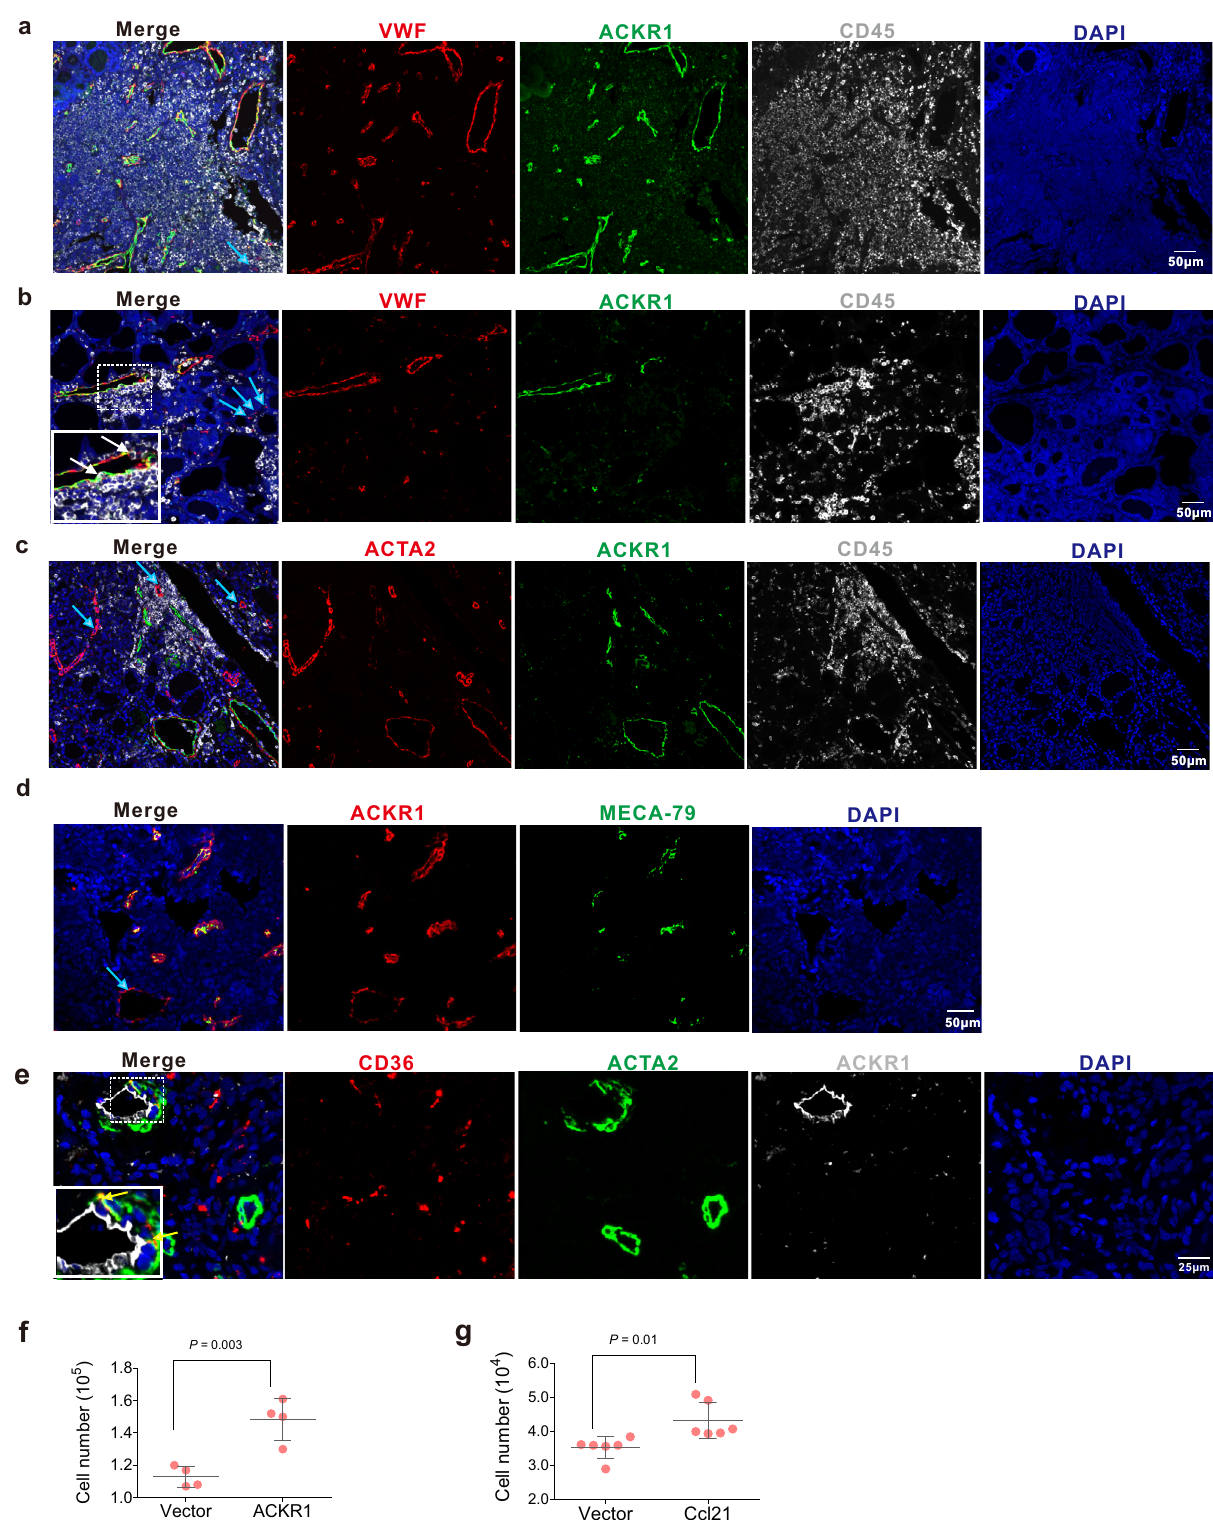
as cytokine production (Supplementary Fig. 4A). Interestingly, in addition to immune cell subgroups, the expression scores of the top markers for stromal cell subgroups EC2 and F1 identi fi ed by Monocle in the thyroid tissues of HT patients were signi fi cantly higher than those of non-HT controls, suggesting HEV EC2 ECs and F1 fi broblasts are increased in thyroid tissues of HT